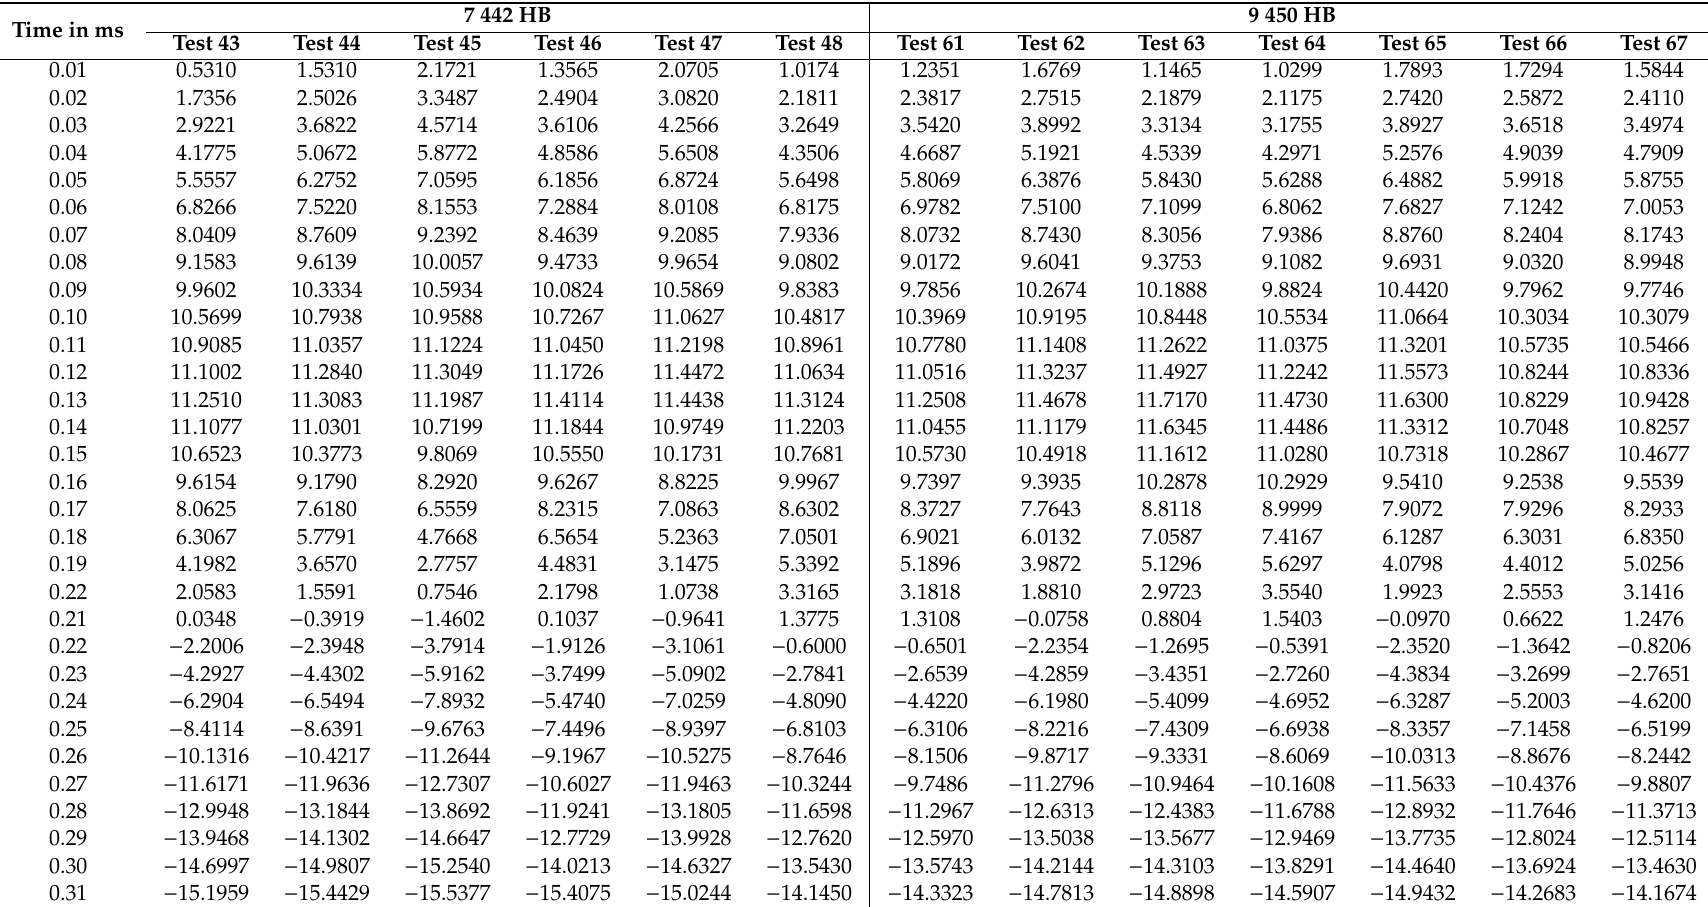
Table A4. Accelerations measured for tests from 43 to 48 and from 61 to